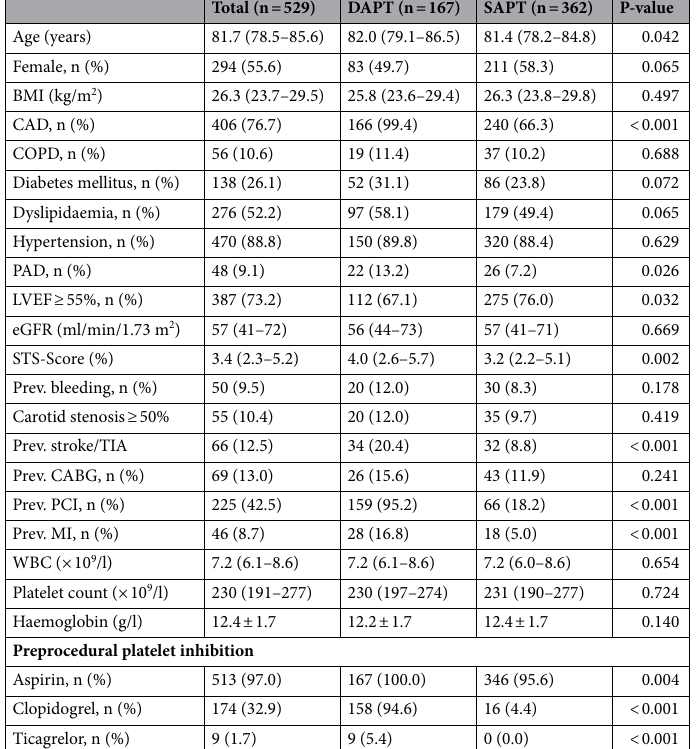
Table 1. Baseline characteristics of patients undergoing TAVR. Values are presented as counts (percentages), median (interquartile range) or mean (± SD). A p-value of < 0.05 was considered statistically significant.